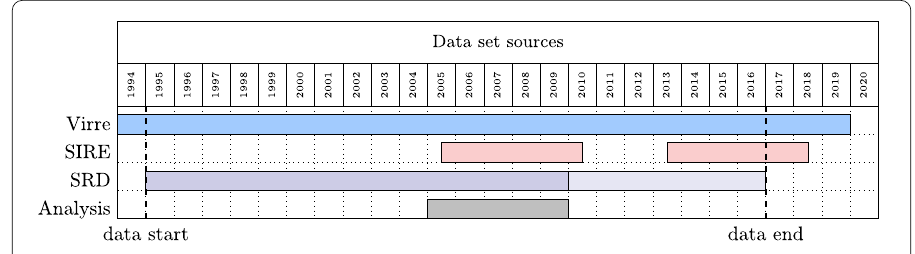
Figure 1 Timeline of the analyzed data sets. The observations in the Virre data set are available starting from April 1962 until November 2019. SIRE data was collected over two non-overlapping periods. The first one covers the period between July 2005 and February 2010, while the second is between March 2013 and September 2018. SRD data set is available for the period between January 1995 until December 2016. The investigated period in the empirical part of this paper ranges between January 2005 and December 2009. In the SRD data from 2010 onwards, the transactions are net aggregated under the registration date, making the estimation of scaled net-volume (Eq. (1)) impossible